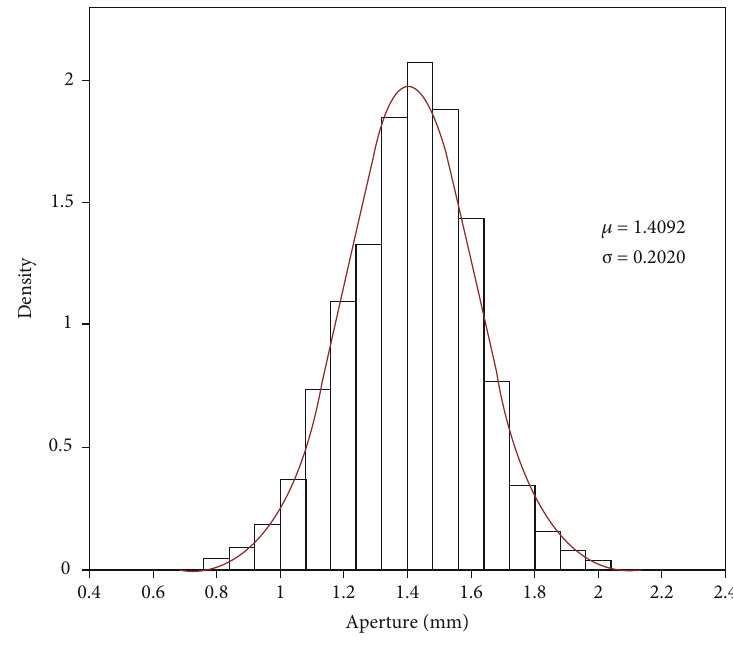
Figure 6: Aperture density distribution.